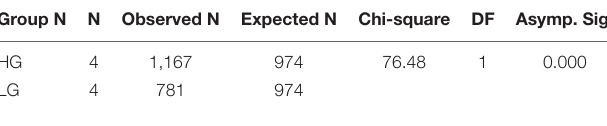
TABLE 3 | Chi-square test for the total number of PTUs of HG and LG teachers. Group N N Observed N Expected N Chi-square DF Asymp.